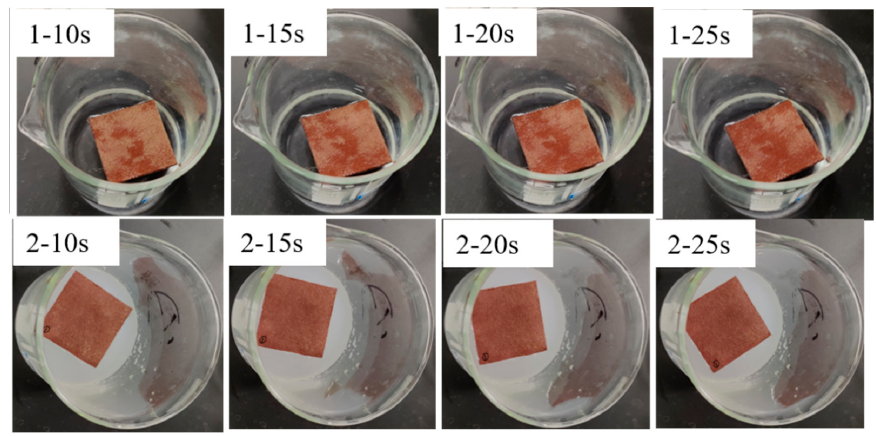
Figure 8. The wetting state of superfine fiber synthetic material (1, blank aqueous solution; 2, 5% NHSi wetting agent solution).